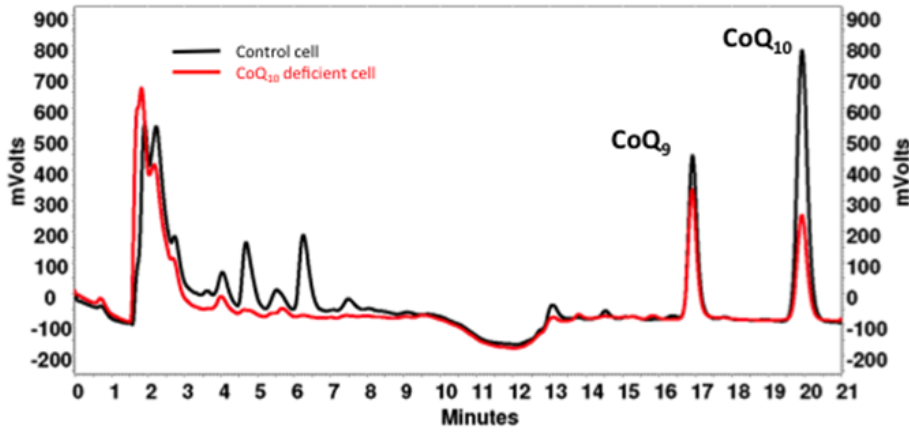
Figure 1. HPLC elution profile of lipid extracts from human skeletal muscular tissue. Patient pathological profile (red plot) shows that CoQ 10 is clearly diminished compared to healthy control volunteers (black plot). CoQ 9 is used as internal standard for normalization.